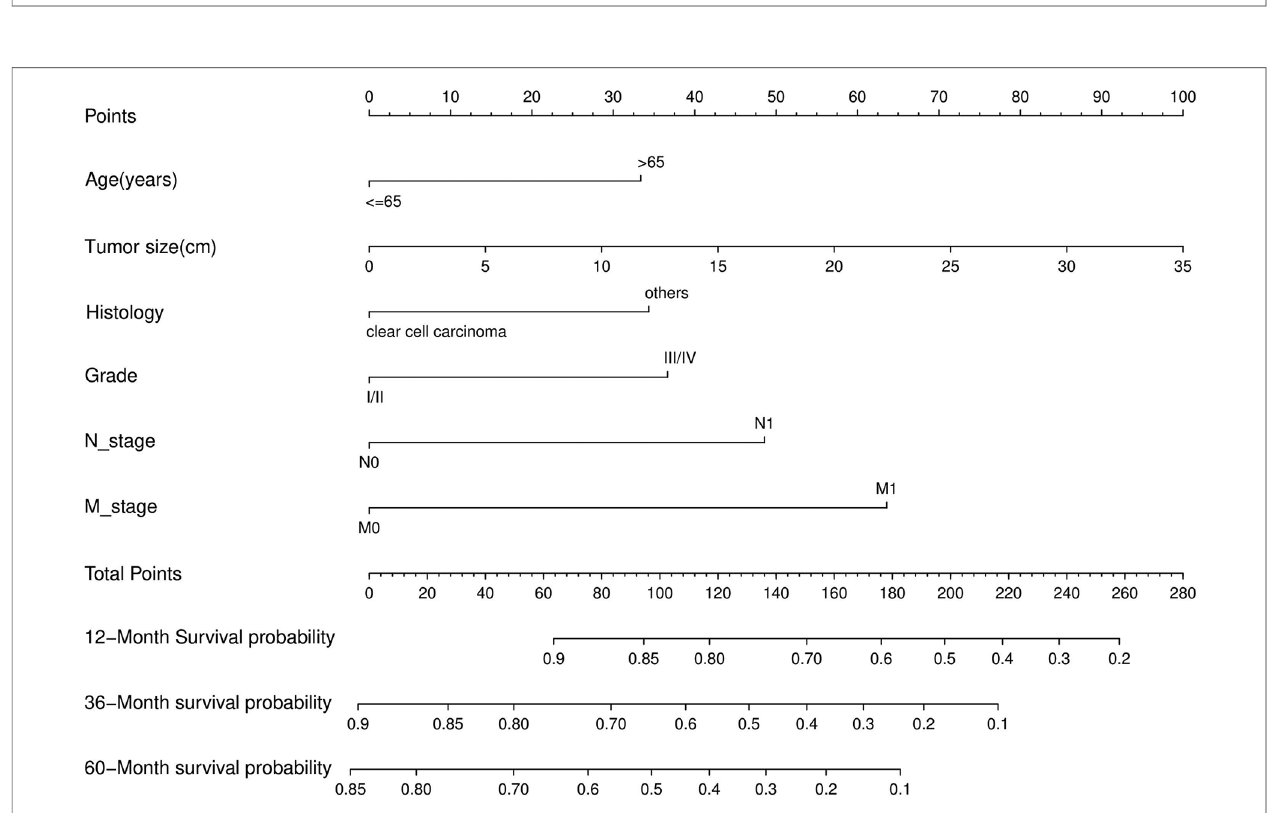
FIGURE 2 | Nomogram for predicting postoperative OS in patients with renal cell carcinoma complicated with venous tumor thrombus.